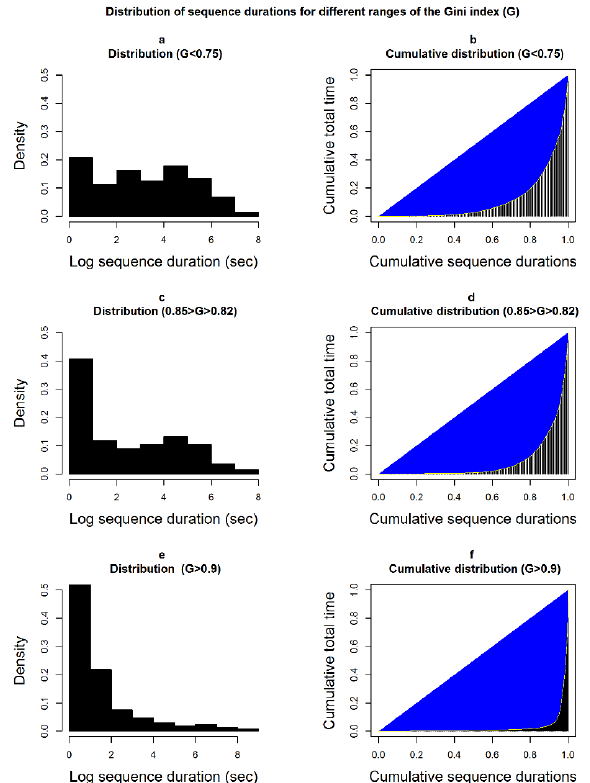
Figure 2. Random non-sedentary sequence durations (sub-figures (a) , (c), (e) ) and their corresponding Lorenz curves, i.e. the total time accumulation by sequence duration (sub-figures (b) , (d) , (f) ), for three different ranges of the Gini index: low (G<0.75; sub-figures (a) and (b) ), medium (0.85>G>0.82; sub- figures (c) and (d) ) and high (G>0.9; sub figures (e) and (f) ). The durations are randomly drawn